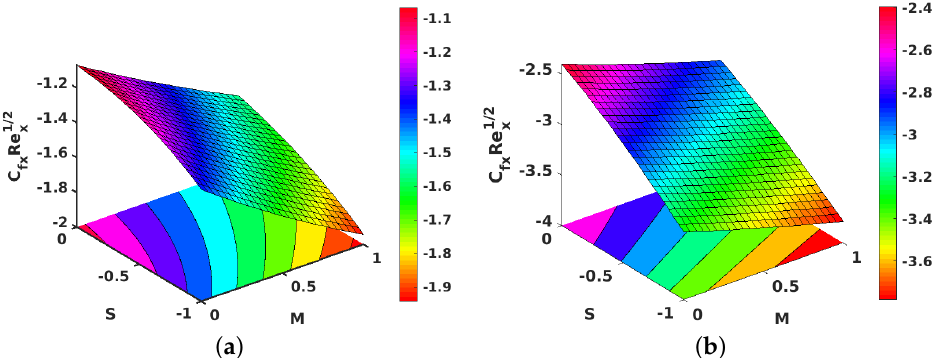
Figure 10. Effect of unsteadiness parameter ( S ) and magnetic parameter ( M ) on the local skin friction coefficient. ( a ) Injection; ( b ) suction.